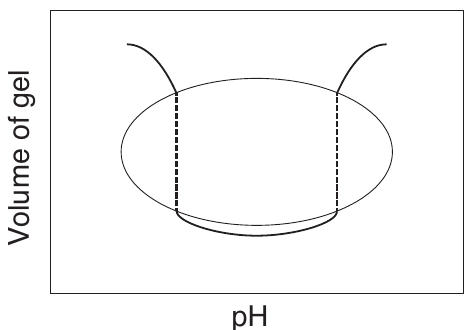
Figure 10. A simple estimation of the swelling curve of gel that contains both the positive charges and the negative